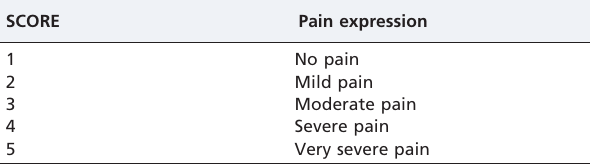
Table 1 - Verbal rating scale.